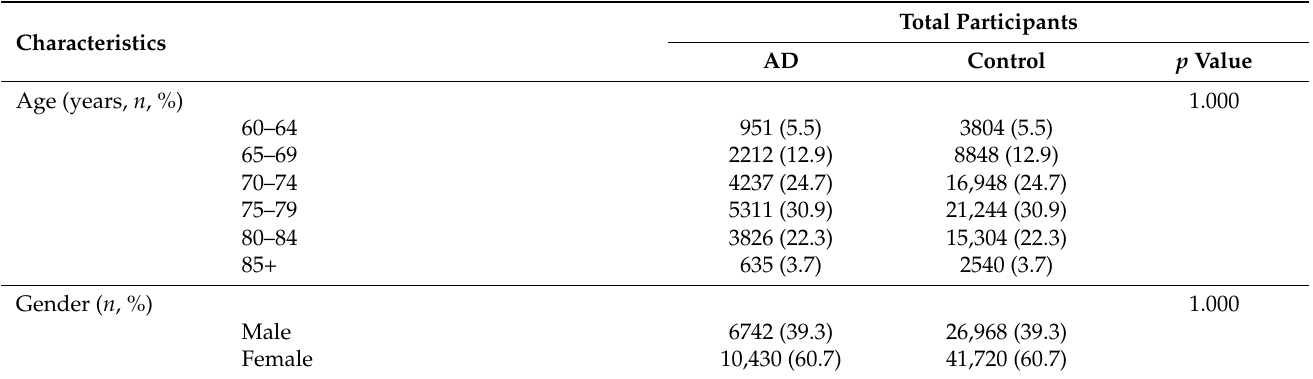
Table 1. General characteristics of